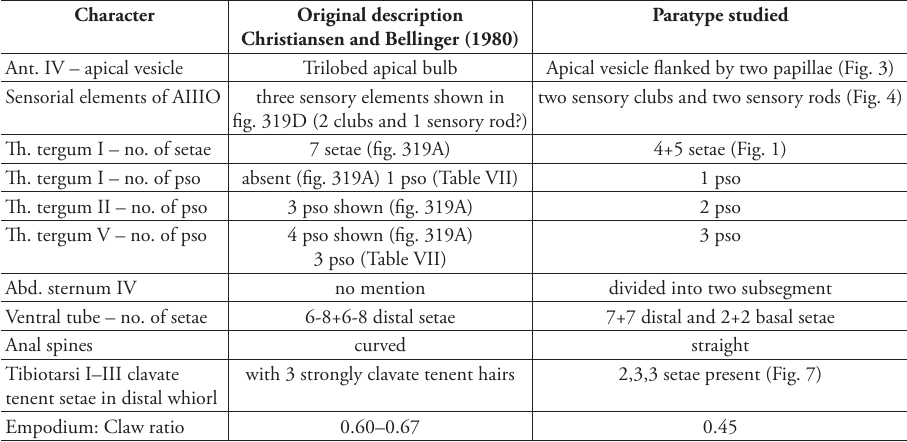
Table 1. Differences between the original description of Chribellphorura allanae and the studied paratype. Character Sensorial elements of AIIIO three sensory elements shown in two sensory clubs and two sensory rods (Fig. fig. 319D (2 clubs and 1 sensory rod?)